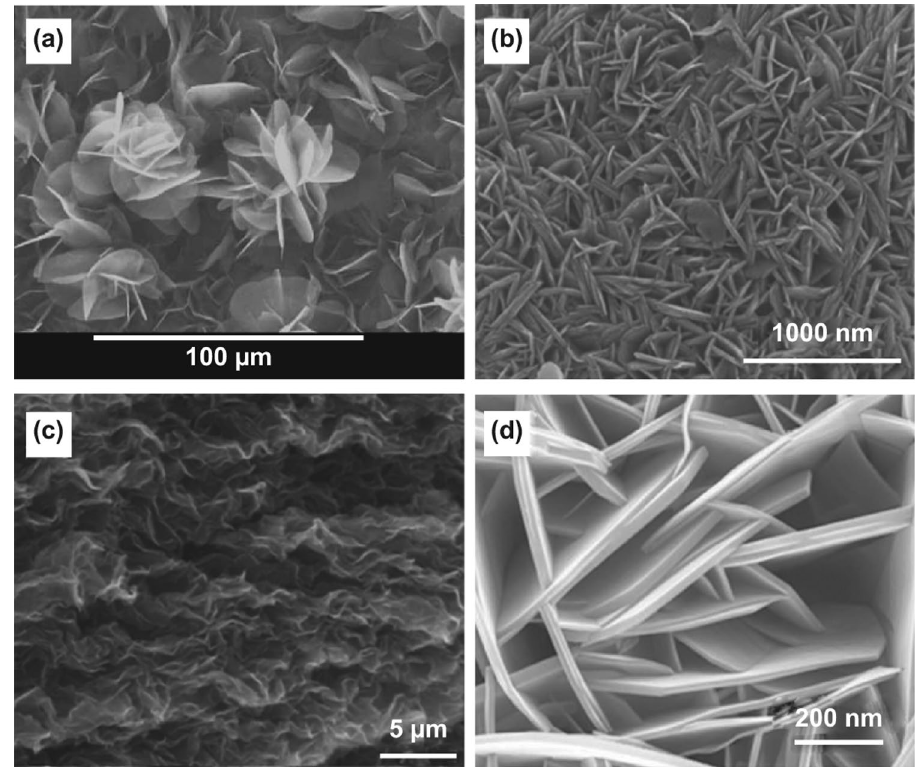
Fig. 15 Electrodeposited two‑dimensional conducting polymers. a Oligopyrene nanosheets; b PPy nanosheets; c PANI nanosheets on graphene sheets; d PEDOT thin films on CoAl layered double hydroxide nanoplates. Adapted from a Ref. [162], b Ref. [159], c Ref. [160], d Ref. [161] with